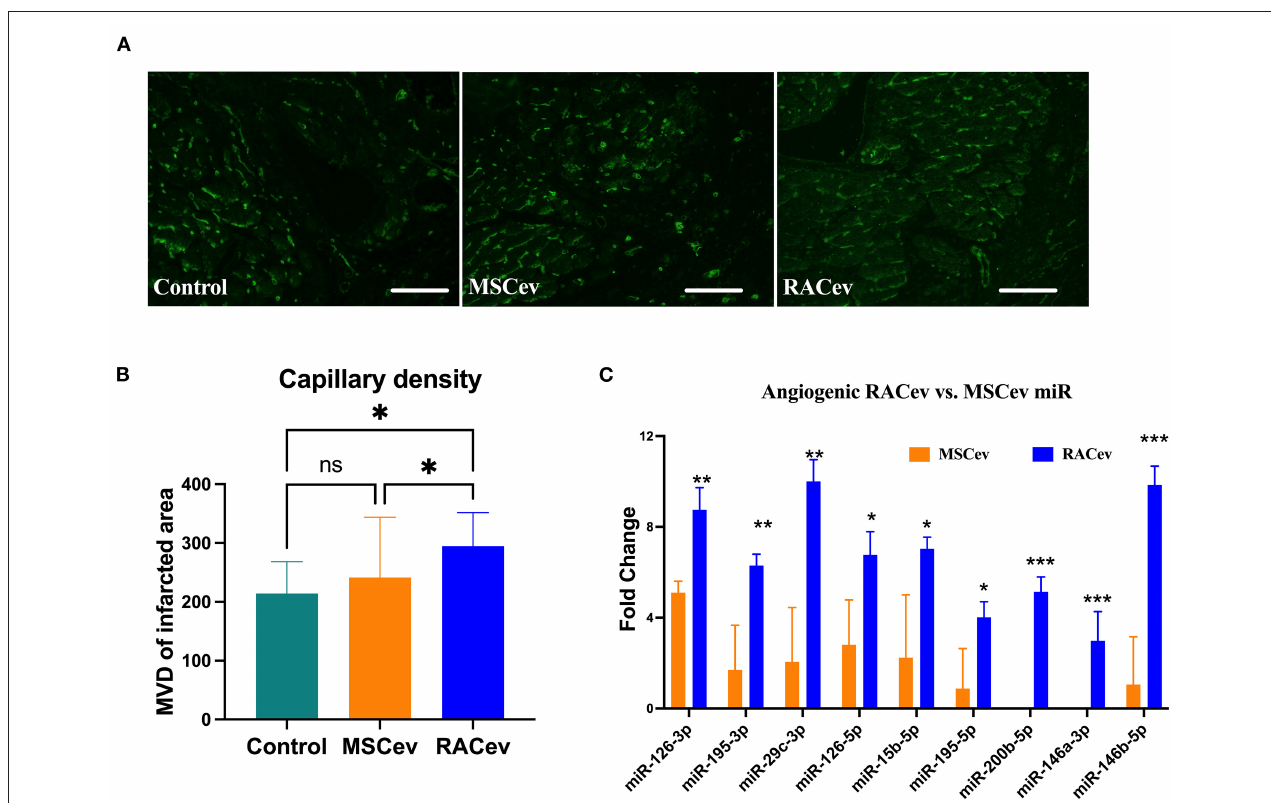
FIGURE 5 | RACev derived angiomiRs enhanced angiogenesis in infarcted tissues. (A,B) Microvascular density was enhanced in myocardial infarcted tissue in RACev transplanted group. Cardiac capillaries were stained with FITC conjugated Isolectin B4 (green) (C) Mechanistically, enhanced capillary formation in injured myocardium may couple with well-known angiomiRs (miR-126-3p and 5p, miR-195-5p, etc.) delivery by RACev. Scale bar = 50 µ m. * P < 0.05; ** P < 0.01; *** P < 0.001 vs. MSCev group; Statistical significance was determined using Kruskal-Wallis followed by Dunn’s multiple comparisons post- hoc test. Results are presented as the mean ± SEM ( n = 8–10 per